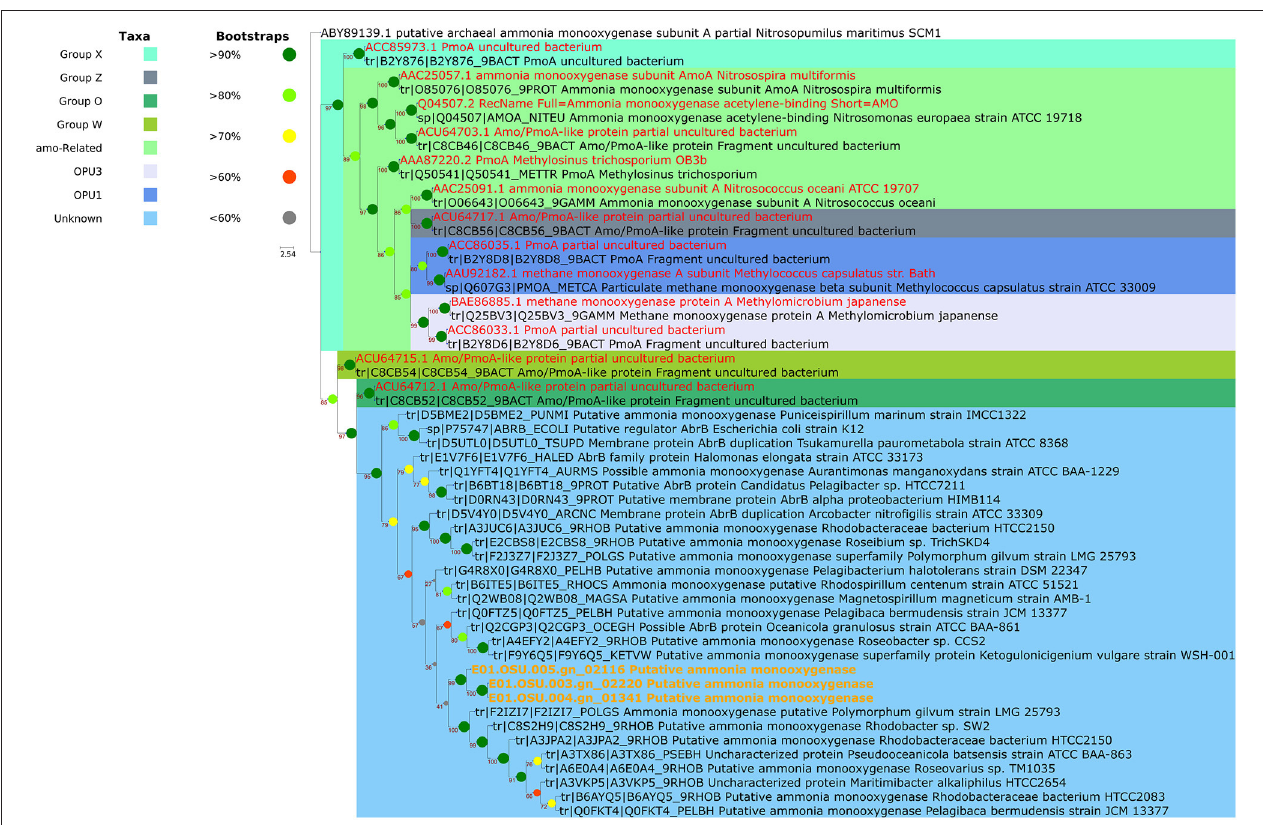
FIGURE 5 | Phylogenetic placement of E01-9C-26 monooxygenase genes annotated as “putative ammonia monooxygenase". The functions of these proteins are unknown, but their relationships to proteins of proven function indicate they may be methane or ammonium monooxygenases. Monooxygenase clades are named according to Tavormina et al. (2010), who reported abundant monooxygenase genes in the mesopelagic of the Sargasso Sea and in California coastal samples. Related sequences are present in a number of cultured oligotrophic marine bacteria in the High Throughput Culturing Collection